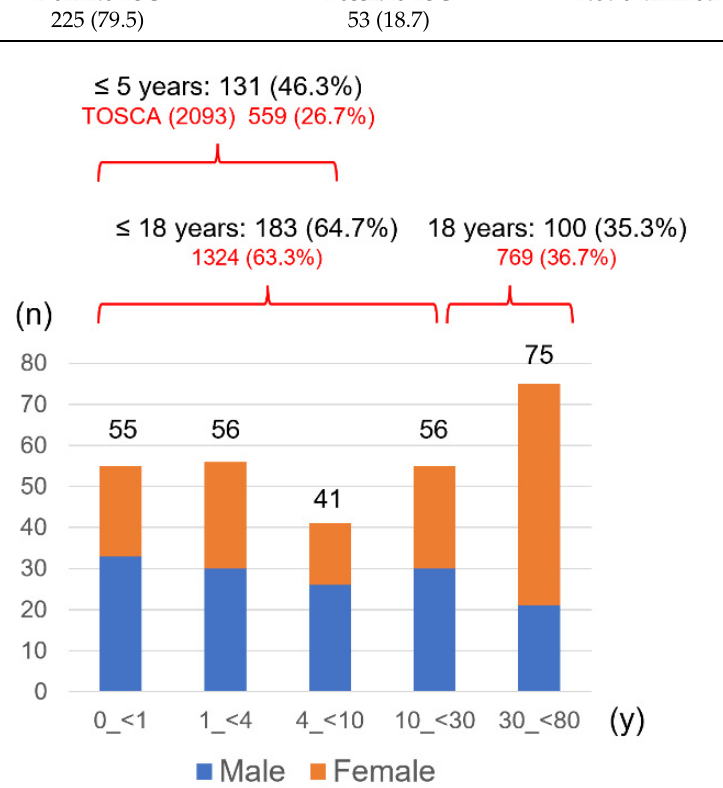
Figure 1. Patient distribution by age in this study ( n = 283).